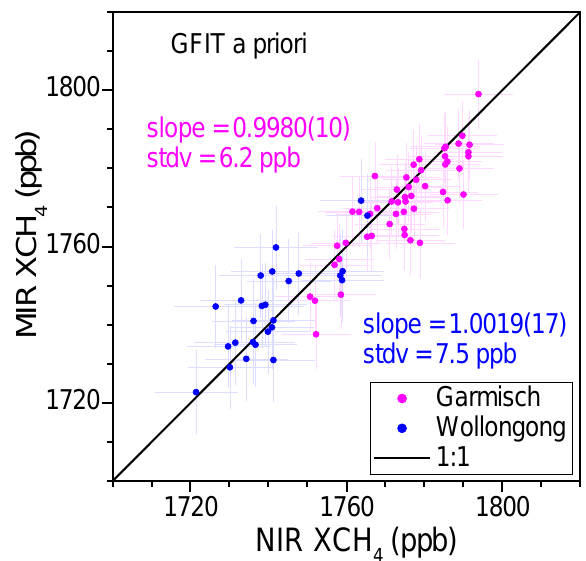
Fig. C5. Same as Fig. 4 but using the GFIT 2009 a priori profile as a common prior for the MIR and NIR retrievals.